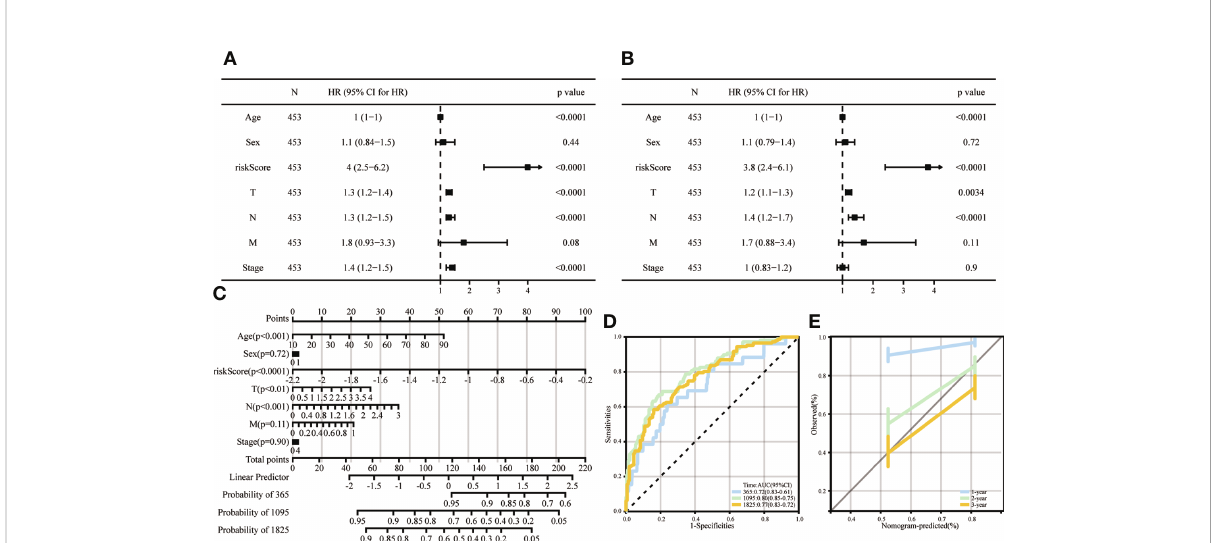
FIGURE 8 Columnar line graphs of TME risk characteristics for predicting survival in melanoma patients. (A, B) Forest plots from univariate and multivariate Cox regression analyses, including risk score, age, sex, grade and stage. (C) Columnar plots of risk scores and stages were used to predict survival at 1, 3 and 5 years in melanoma patients. (D) Time-dependent ROC curve analysis shows that column line graphs are reliable and stable predictors of OS at one year, three years and fi ve years. (E) Calibration curves show the column line graphs ’ predicted (x-axis) and actual survival probabilities